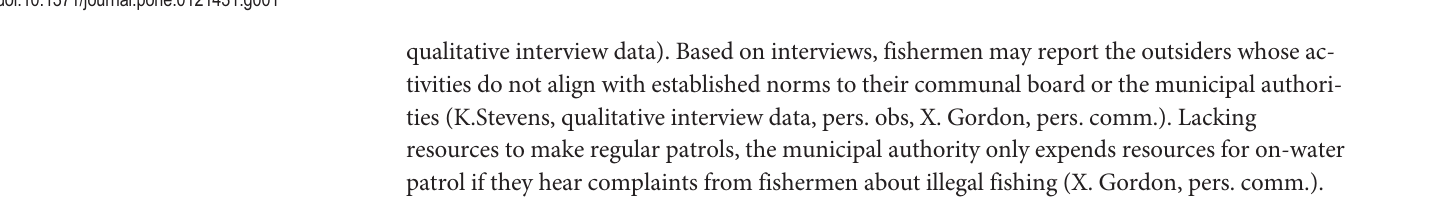
PLOS ONE | DOI:10.1371/journal.pone.0121431 March 30,